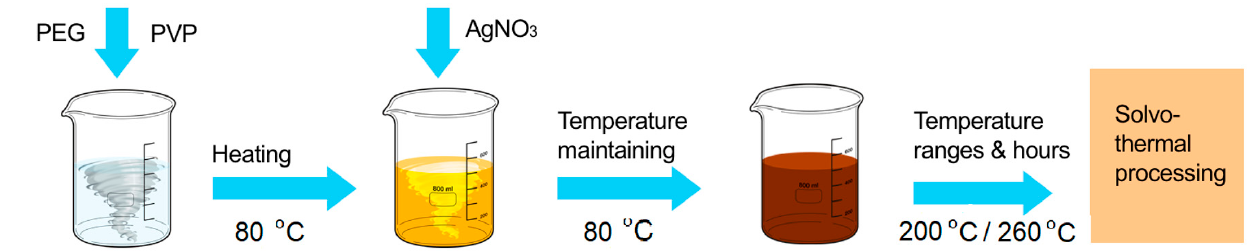
Figure 2. The technology line for the chemical route at the raised temperature (solvothermal synthesis). Table 2. Components and conditions of solvothermal synthesis .